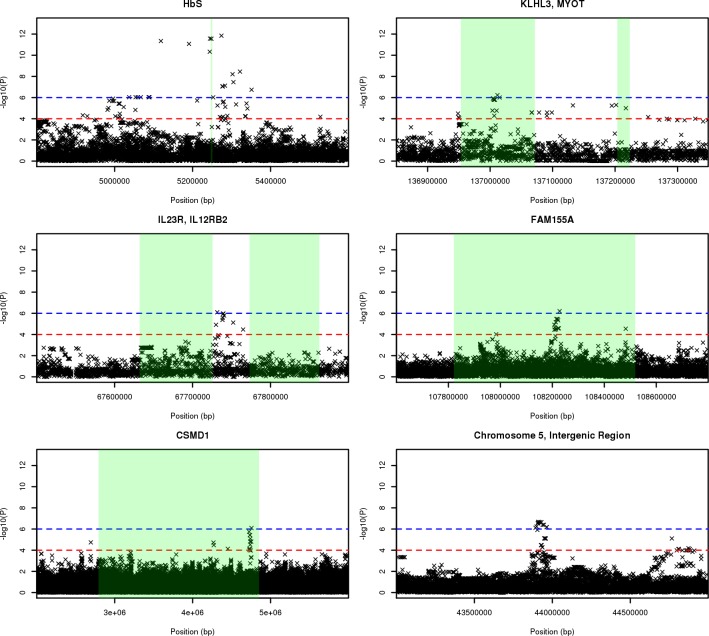
Region plots for most significant SNP associations.Green regions highlight genes of interest, as indicated by sub-plot headers. The red line indicates genome-wide significance at 1x10-6, whilst the blue line indicates genome-wide suggestive significant at 1x10-4.